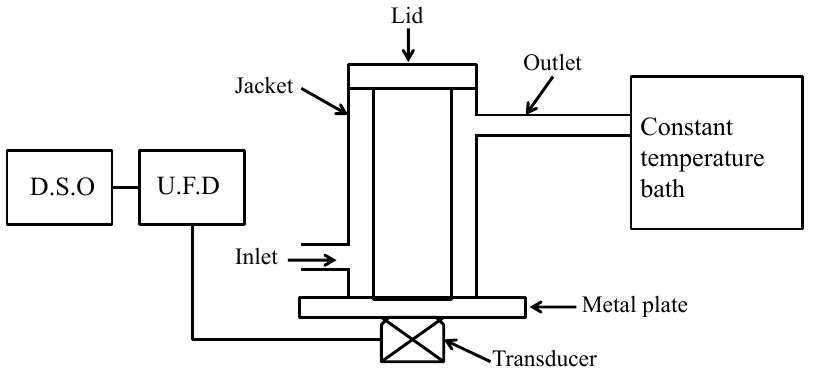
Figure 2. Schematic diagram of the experimental setup.